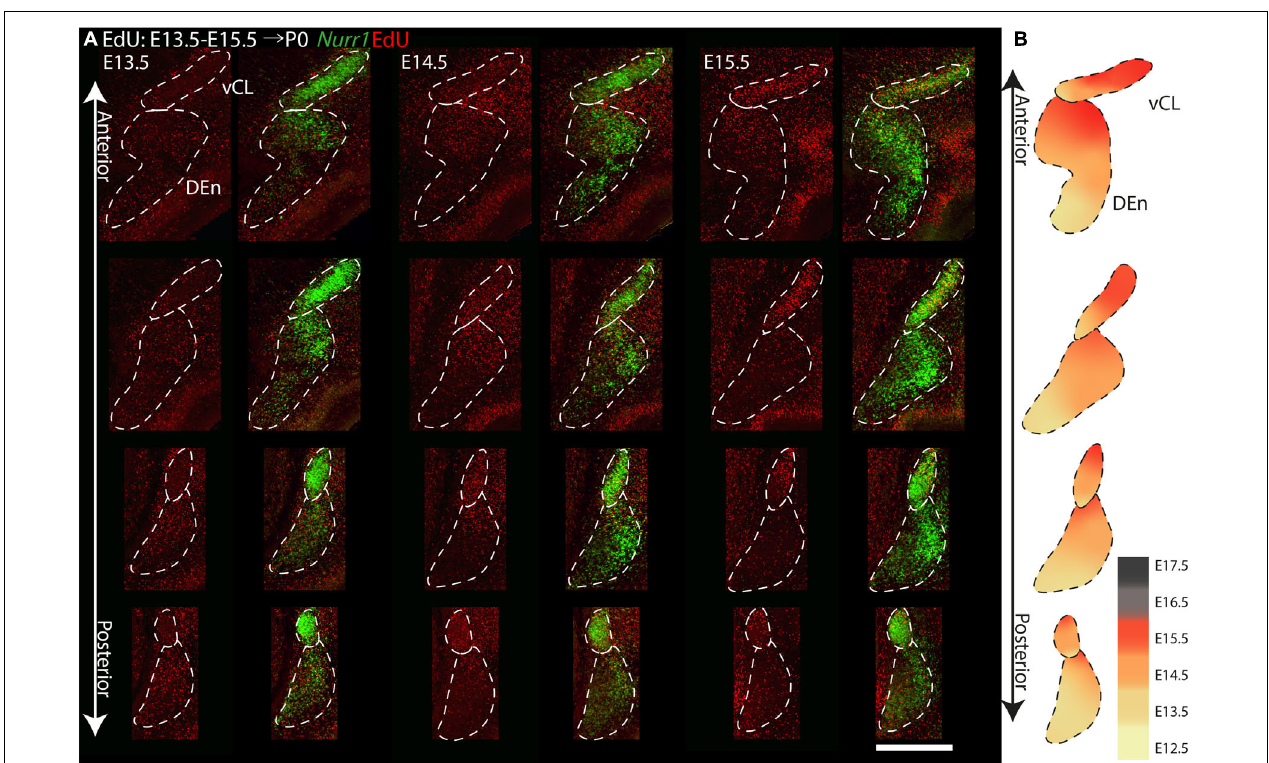
FIGURE 13 | Gradients of neurogenesis in the Nurr1 labeled CL and DEn from anterior to posterior. (A) High magnification Nurr1 labeled posterior claustrum related regions, including CL and DEn with E13.5 to E15.5 EdU labeling. (B) Schematic diagram of the CL and DEn. EdU signals in different regions from E12.5 to E17.5 shown as indicated by the color bar. Scale bar in panel (A) = 0.5 mm.